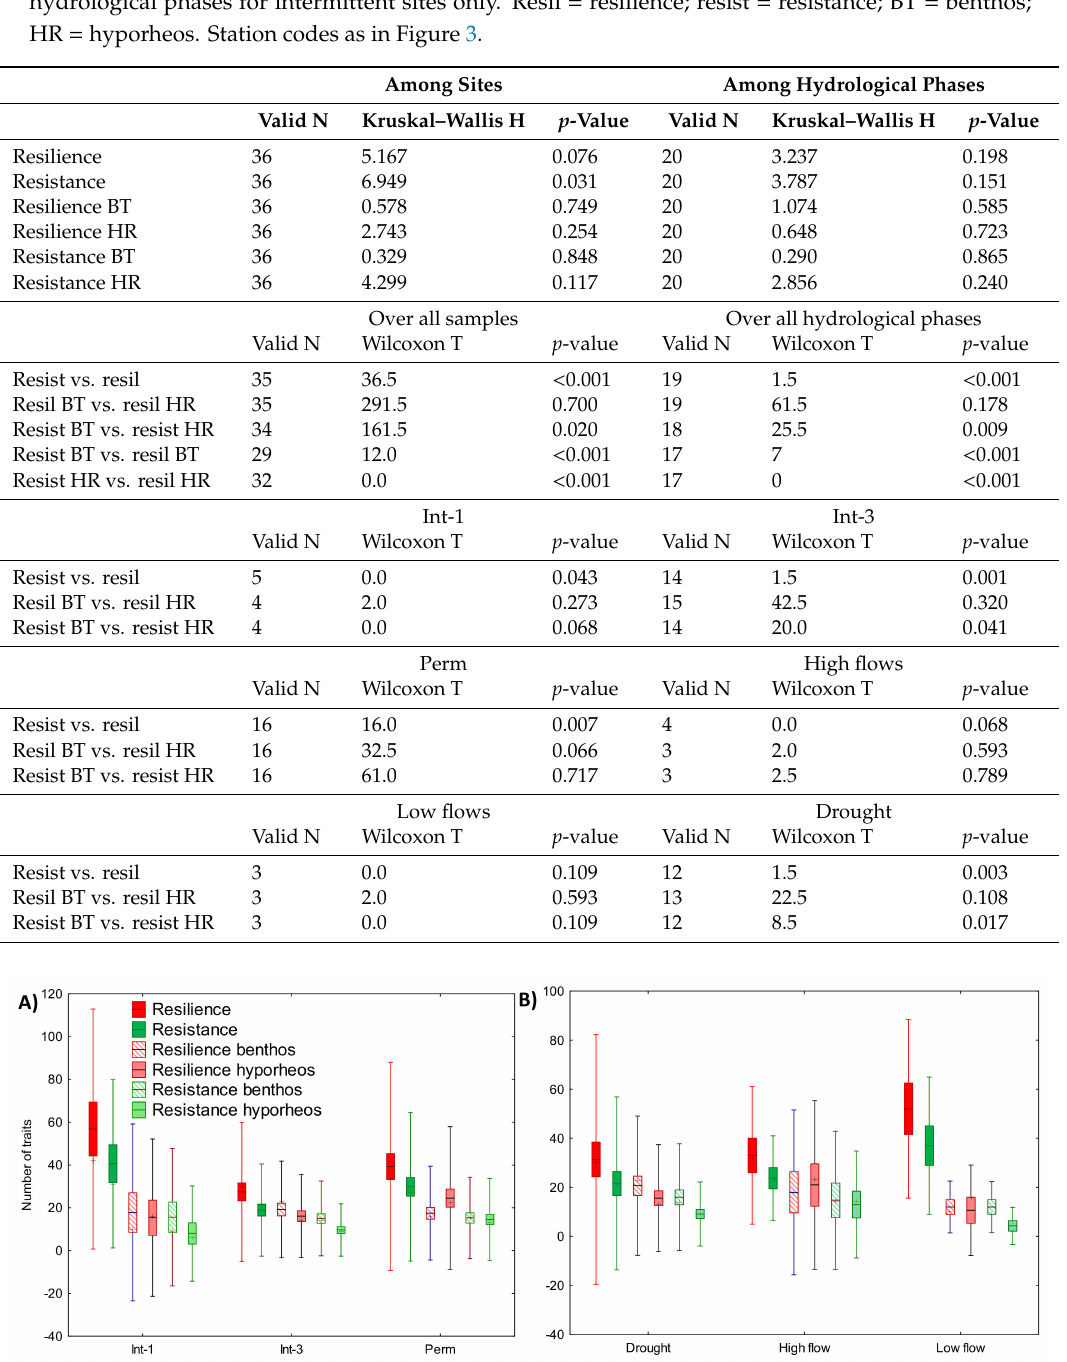
Figure 7. Box-plots of each trait typology, for hyporheic and benthic assemblages by: ( A ) sampling site; ( B ) hydrological phase at intermittent sites (right). Line: Mean; box: Mean ± SE; whisker: Mean ± 2*SD; cross: median. Station codes as in Figure